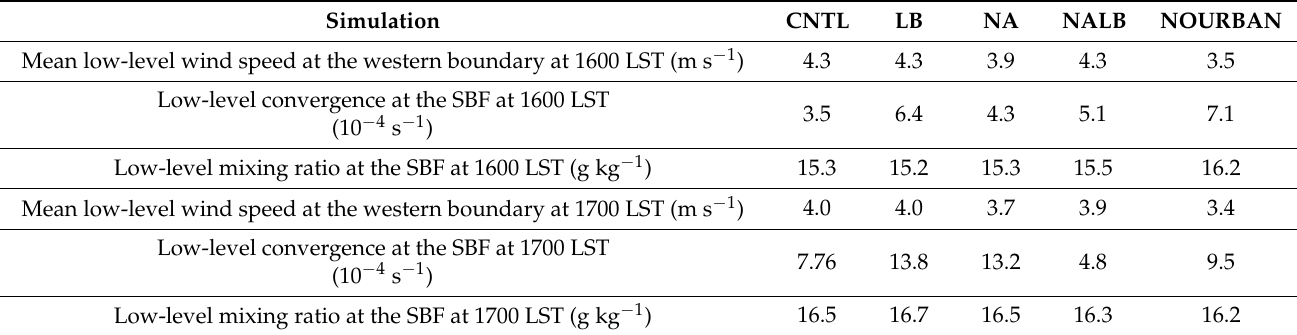
Table 6. Summary of meridional-averaged sea breeze features in the analysis domain. Here, the low level indicates below the fifth model level (around 570 m a.g.l.). Simulation CNTL LB NA NALB